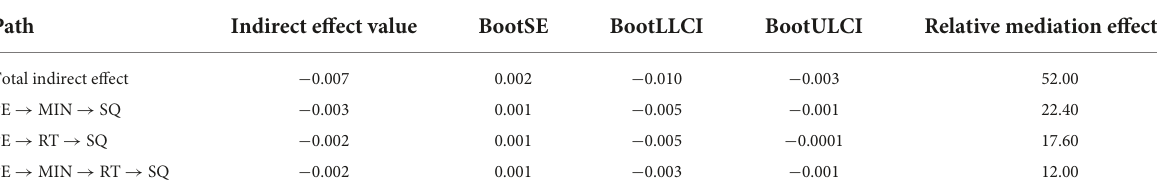
TABLE 3 Test of intermediary